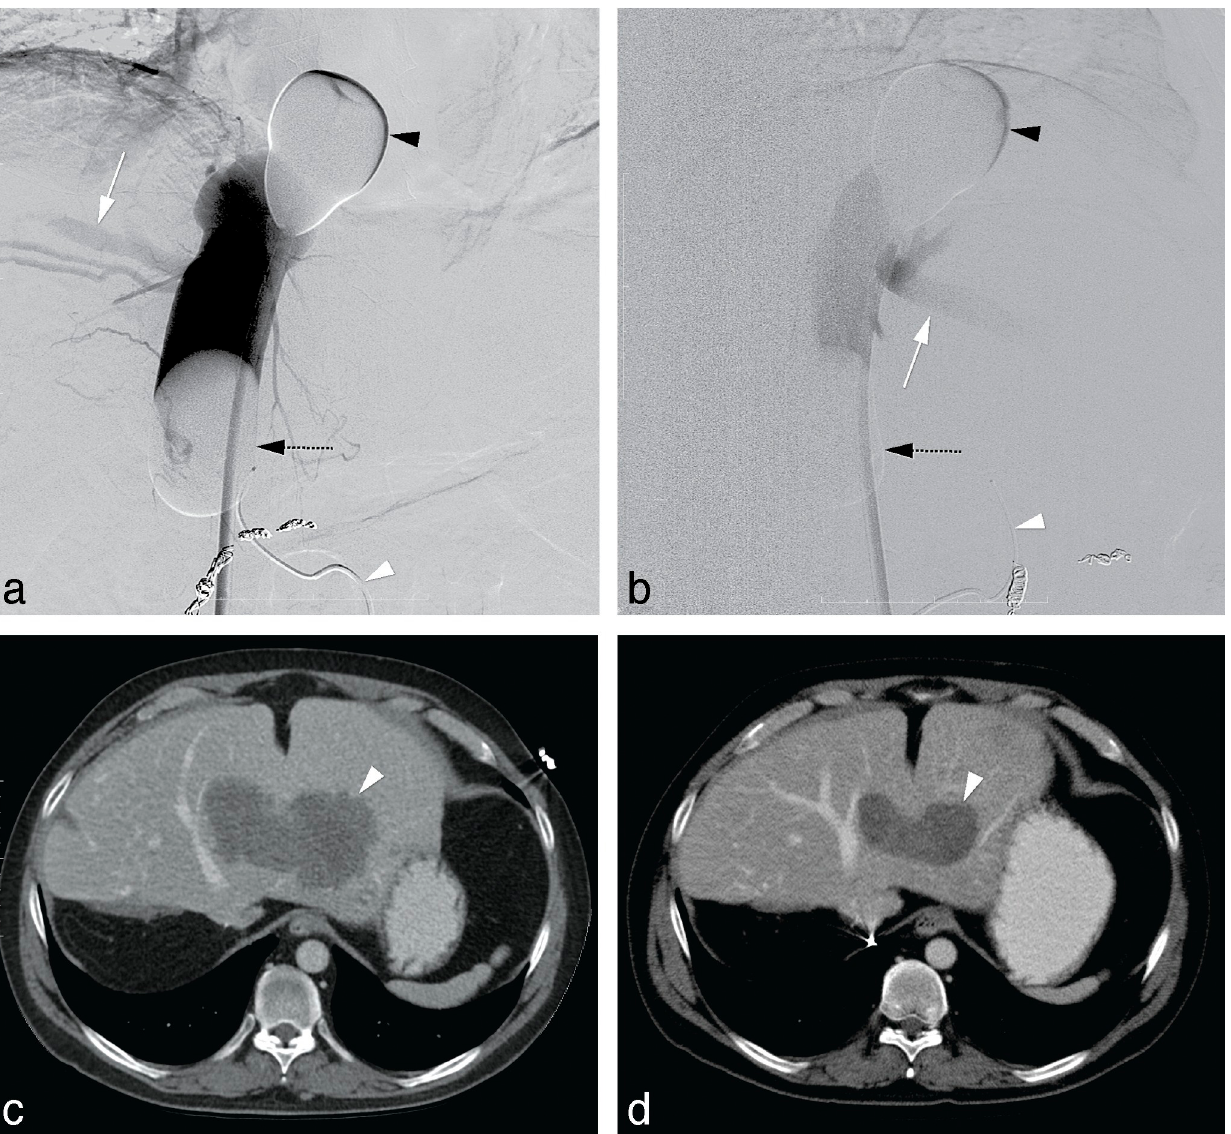
Fig 2. M-PHP in a 46-year-old male with a solitary liver metastasis from colorectal carcinoma in the left liver lobe after previous radiofrequency ablation in liver segment 2, metastasectomy of liver segment 4, and a right hepatectomy. (a-b) Postero-anterior and lateral images during venography, performed by manual injection of non-diluted contrast medium through side holes of the double-balloon catheter. The cranial balloon ( black arrowhead ) was inflated at the atriocaval junction and the caudal balloon ( dotted black arrow ) in the infrahepatic portion of the inferior vena cava. Note the opacification of both the right hepatic vein ( white arrow in a ) and middle hepatic vein ( white arrow in b ), while there was no leakage alongside the balloons. A microcatheter ( white arrowhead ) was placed into the hepatic artery proper for the infusion of melphalan. Note also the coils after successful embolization of the right gastric artery and gastroduodenal artery. (c) Axial CT image before treatment showing a solitary hypovascular lesion ( white arrowhead ). (d) Axial CT image after two cycles of M-PHP showing reduction in size of the lesion ( white arrowhead ) corresponding with partial response.